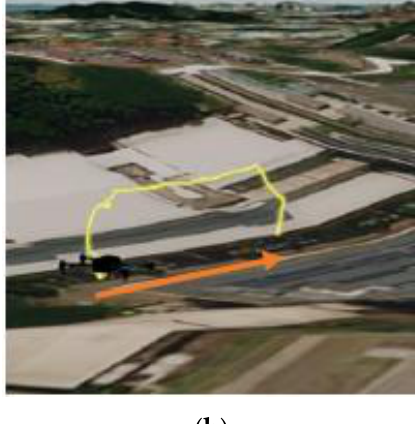
Figure 2. ( a ) Carpark N3.1, NTU. ( b ) Flight Path at Carpark N3.1.